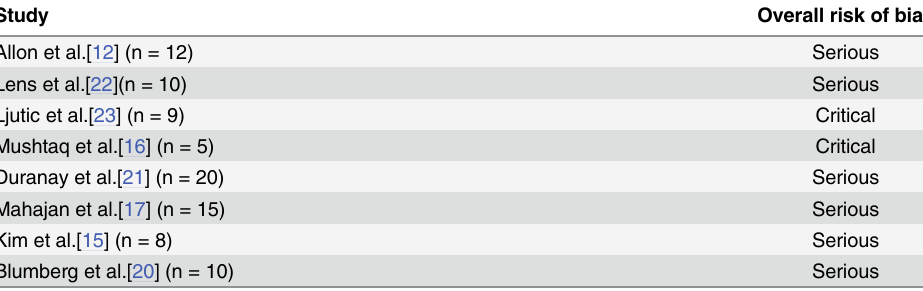
Table 3. Overall risk of bias for non-randomized trials.